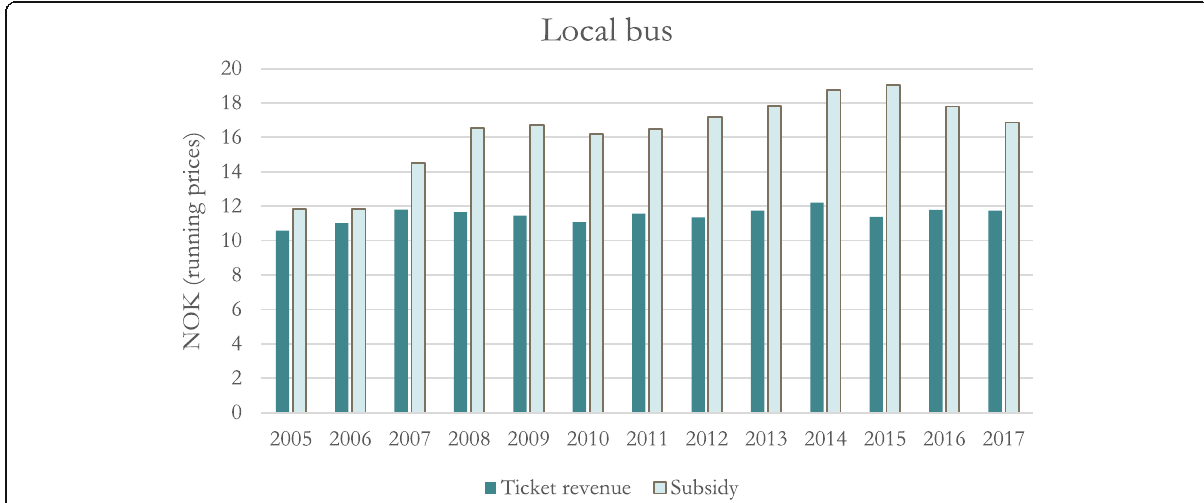
Fig. 1 Ticket revenues and subsidies per bus trip in Norway, 2005-17. NOKs (the average exchange rate over the period was NOK 8.3= € 1). Source: Statistics Norway source table 06668